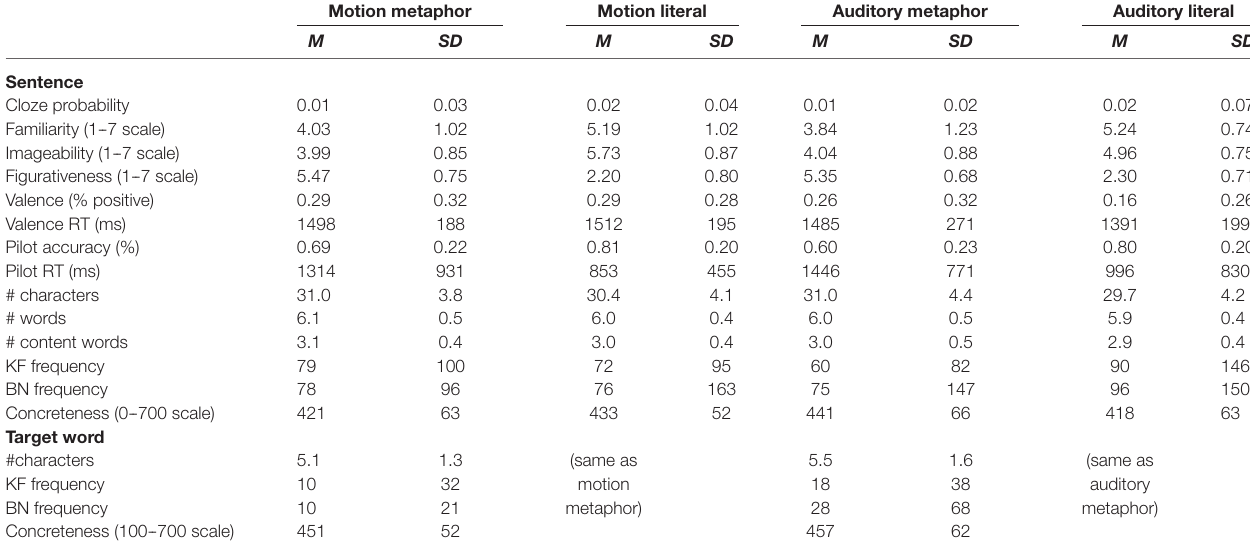
TABLE 2 | Characteristics of the final stimuli . Motion metaphor Motion literal Auditory metaphor